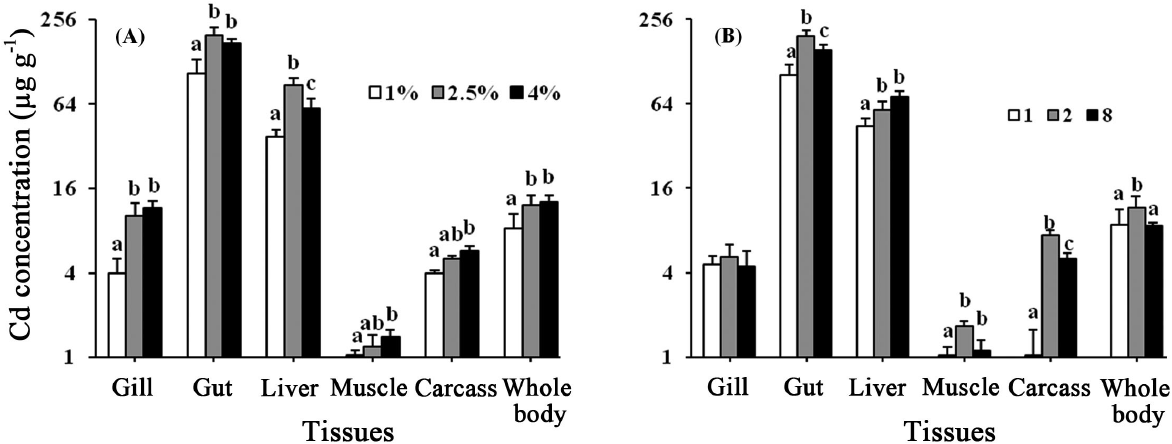
Fig. 4. Cadmium concentration (µg Cd g –1 in dry matter) in the gills, gut, liver, muscle, carcass and whole body of black sea bream Acanthopagrus schlegeli exposed to dietary Cd (254.4 µg g –1 ) for 5 wk at 3 different levels of feeding ratio (FR) or fre- quency (FF). (A) FR treatment: fish were fed 1, 2.5 and 4% body weight d –1 at a FF of 2 times d –1 . (B) FF treatment: fish were fed 1, 2 and 8 times d –1 at a FR of 3% body weight d –1 . Mean ± SD, n = 6 (3 fish per replicate tank); means of the same tissue with different superscripts are significantly different among treatments (p < 0.05). Note: quadratic scale of y